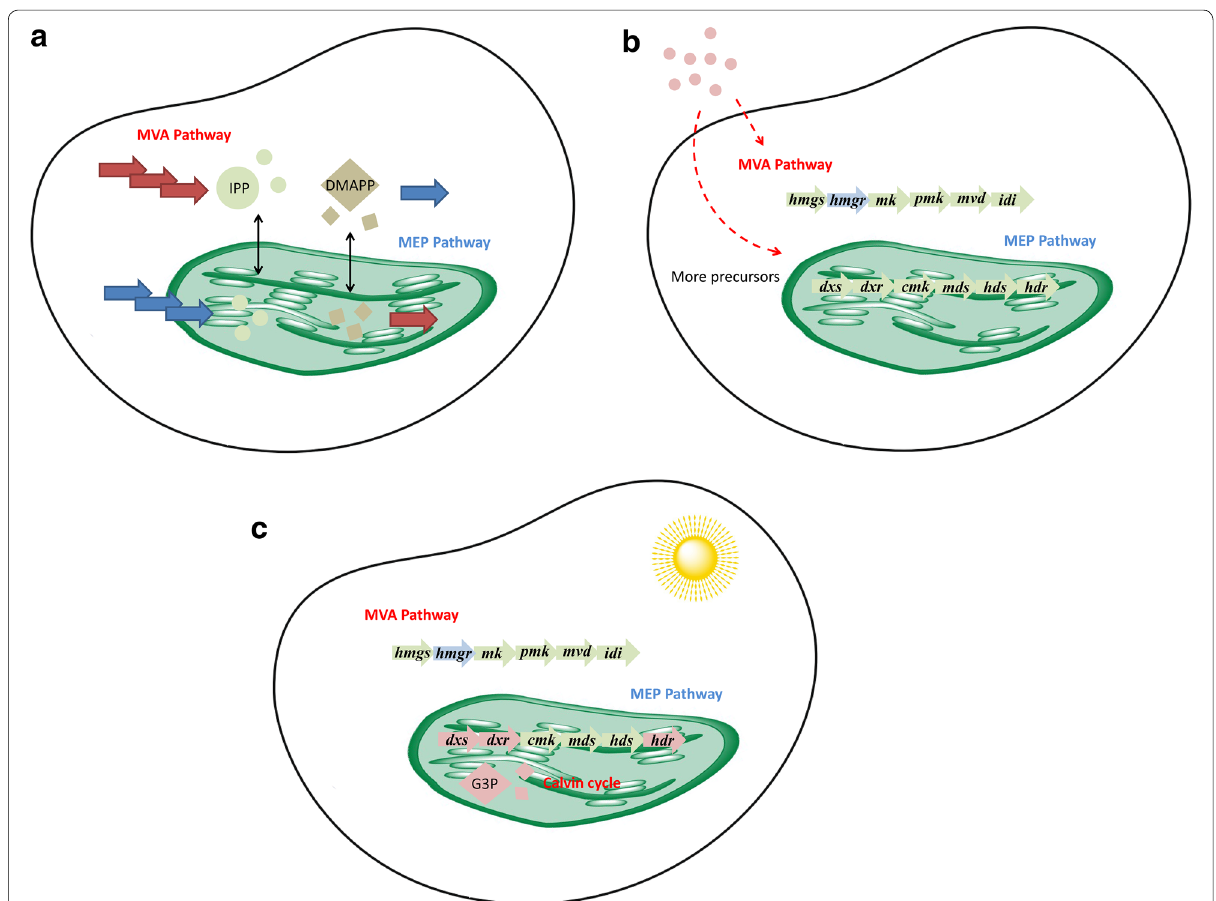
Fig. 3 Enhancing the interaction between the MVA and MEP pathway. a Overexpression of the MVA (MEP) pathway enhances the MEP (MVA) pathway. b Addition of sugar down-regulates the MVA pathway (in blue) and provides sufficient precursors for the MEP pathway. c Light down-regulates the MVA pathway (in blue) and up-regulates the MEP pathway (in